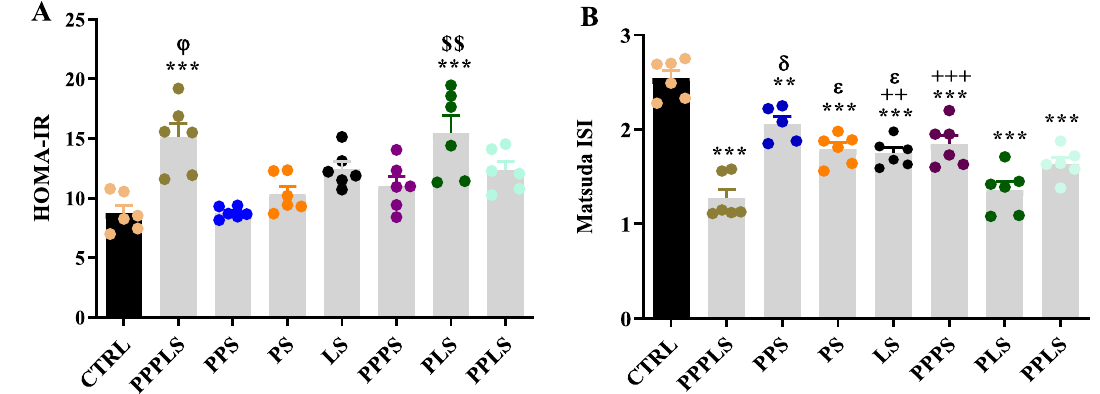
Figure 3. Effect of perinatal stress on HOMA-IR ( A ) and Matsuda index ( B ) in young adult male offspring. Each column represents mean ± SEM (6 rats/group, 6 litters/group); Data was analyzed using one-way ANOVA followed by Tukey’s post hoc test; ** P < 0.01, *** P < 0.001 versus CTRL group; ++ P < 0.01, +++ P < 0.001 versus PPPLS group; $$ P < 0.01 versus PS group; φ P < 0.05 versus PPPS group; ɛ P < 0.05 versus PLS group; δ P < 0.05 versus PPLS group. CTRL non stress, PPPLS pre-pregnancy, pregnancy, lactation stress, PPS pre-pregnancy stress, PS pregnancy stress, LS lactation stress, PPPS pre-pregnancy, pregnancy stress, PLS pregnancy, lactation stress, PPLS pre-pregnancy, lactation